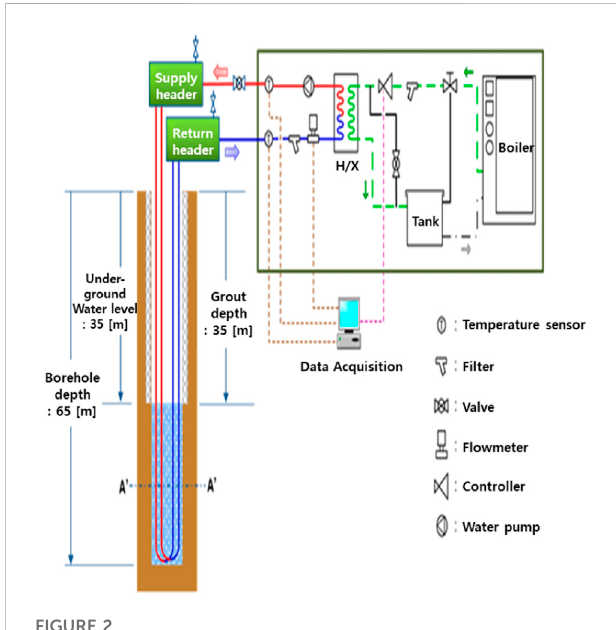
FIGURE 2 Schematic diagram of experimental